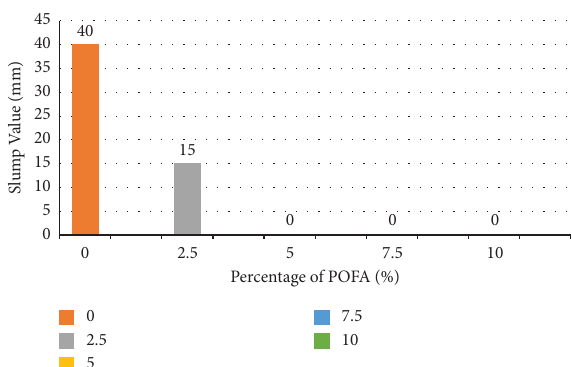
Figure 6: Slump value results on diferent percentages of